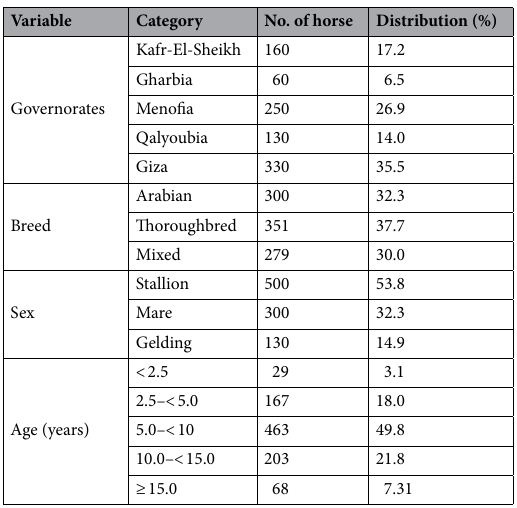
Table 1. Descriptive analysis of variables used to predict the seroprevalence of West Nile virus infection in equine of the Nile Delta of Egypt.